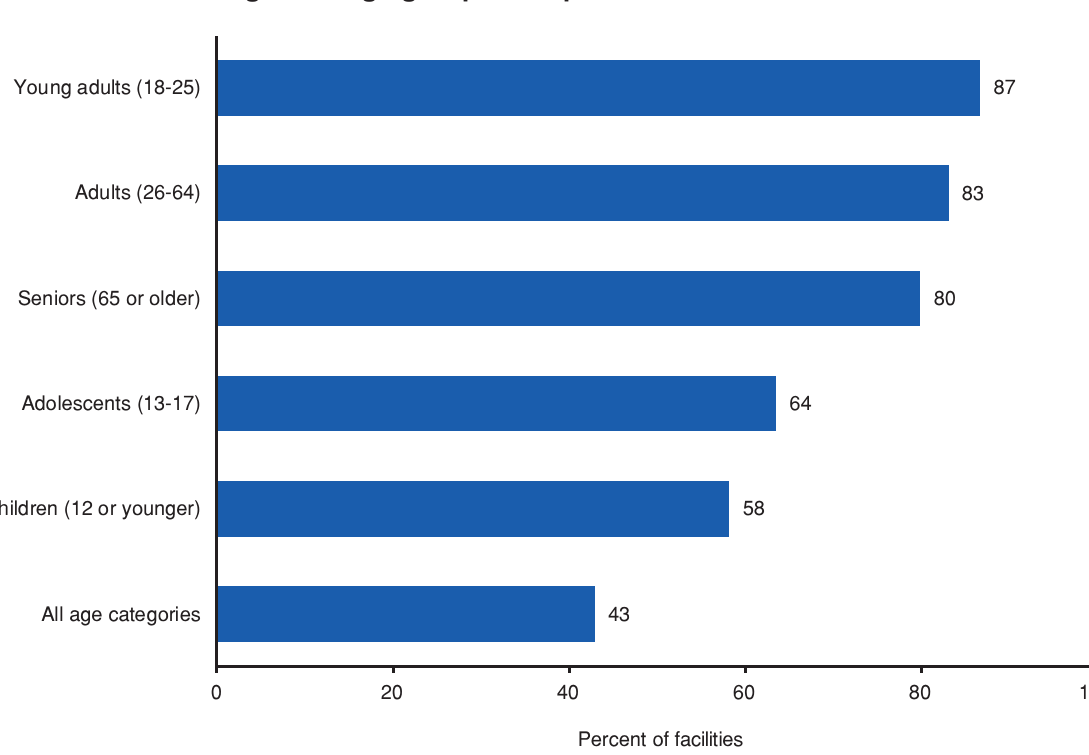
Figure 4. Age groups accepted for treatment: